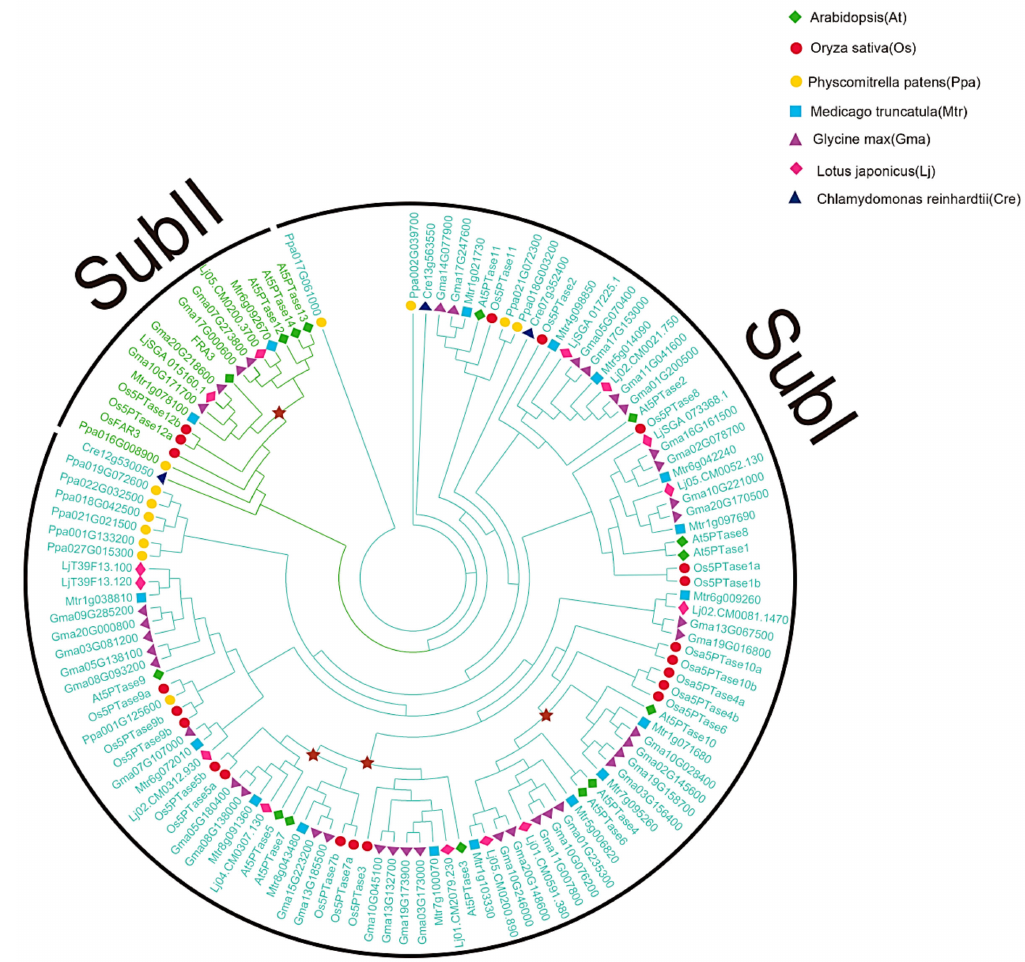
Figure 5. Phylogenetic analysis of plant 5PTase genes. The tree topology of 5PTase protein sequences was constructed by Maximum Likelihood (ML) using the Jones, Taylor, and Thorton model among Arabidospis , rice, moss, Medicago truncatula , soybean, Lotus japonicas, and Chalamydomonas reinhardtii . The 5PTase protein sequences were aligned using MAFFT (MSA tool that uses Fast Fourier Transforms). The red stars represent major duplication